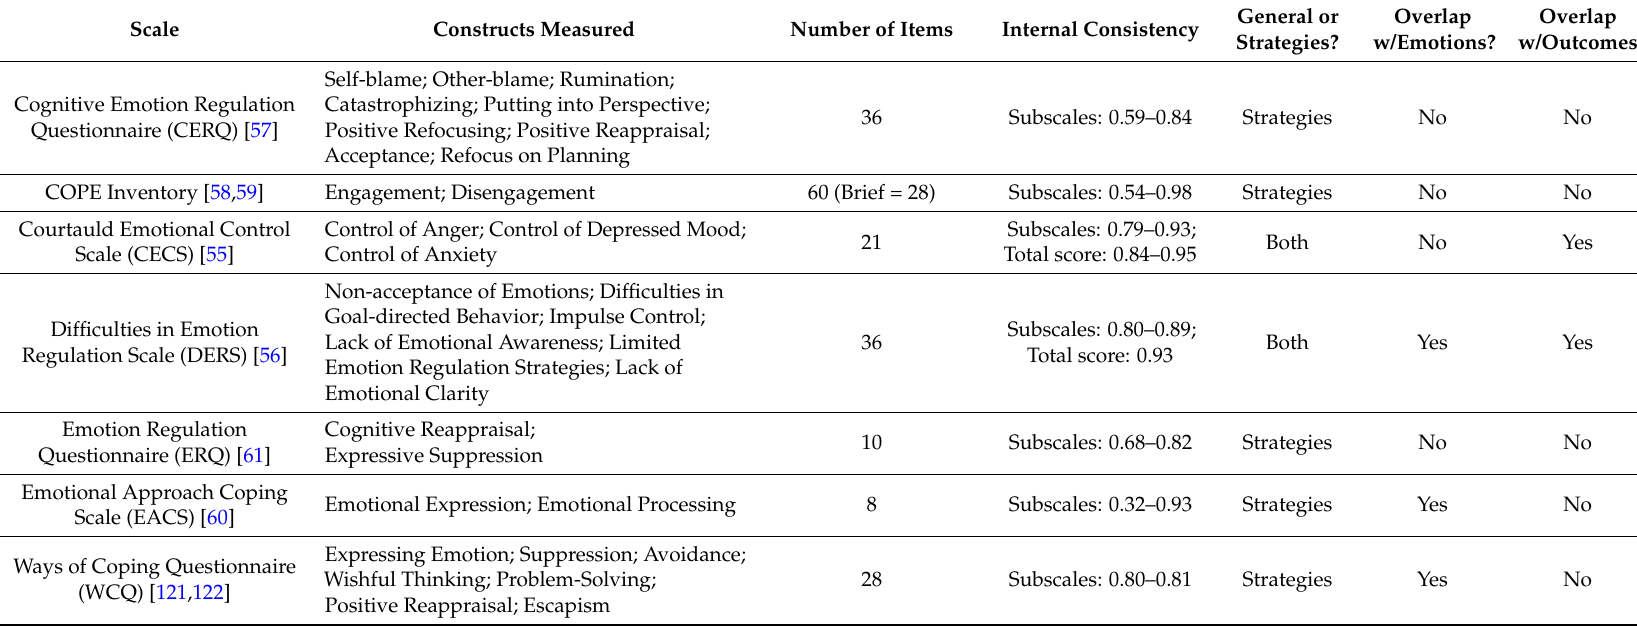
Table 2. Descriptions and psychometric properties of self-report measures of emotion regulation used in